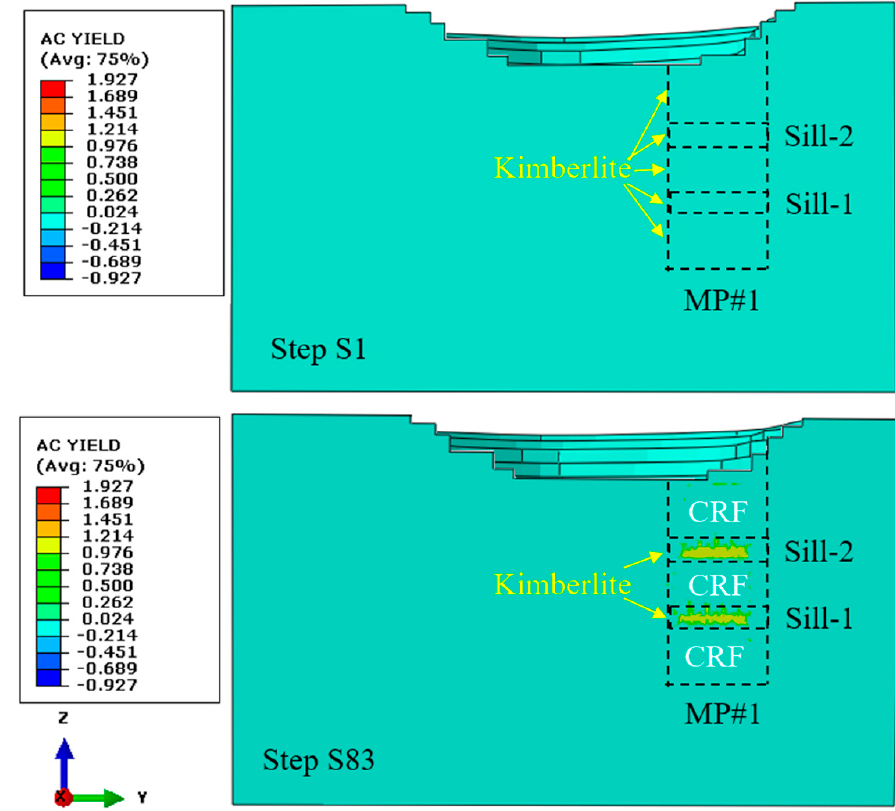
Figure 11. Yield zones in the MP#1 at step S1 and step S83.